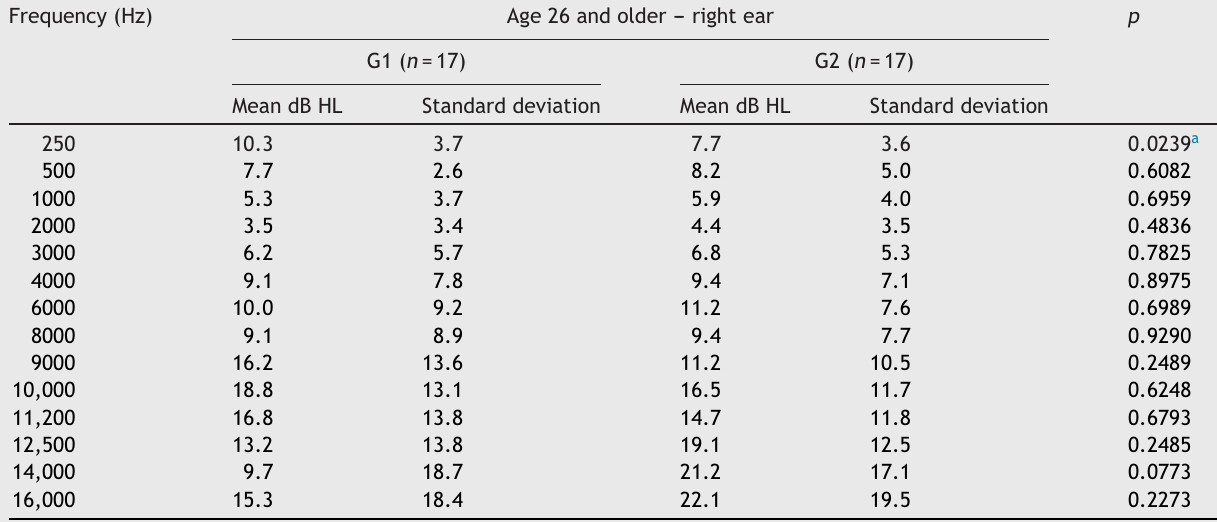
Mean pure-tone air-conduction right ear thresholds, by frequency, for age range 26 and older, in groups G1 and G2 ( n = 34).